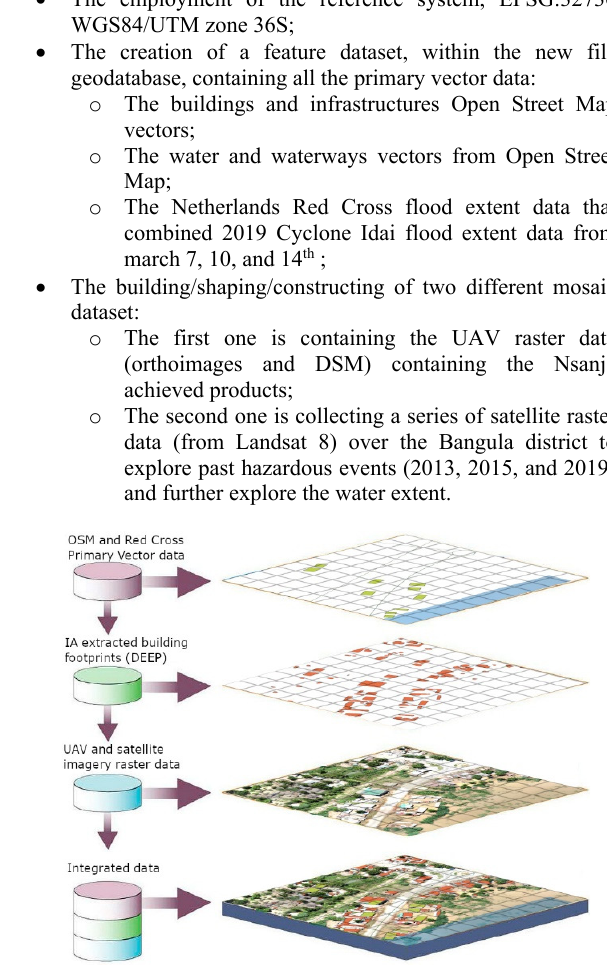
Figure 8. Process map that summarizes the different GIS